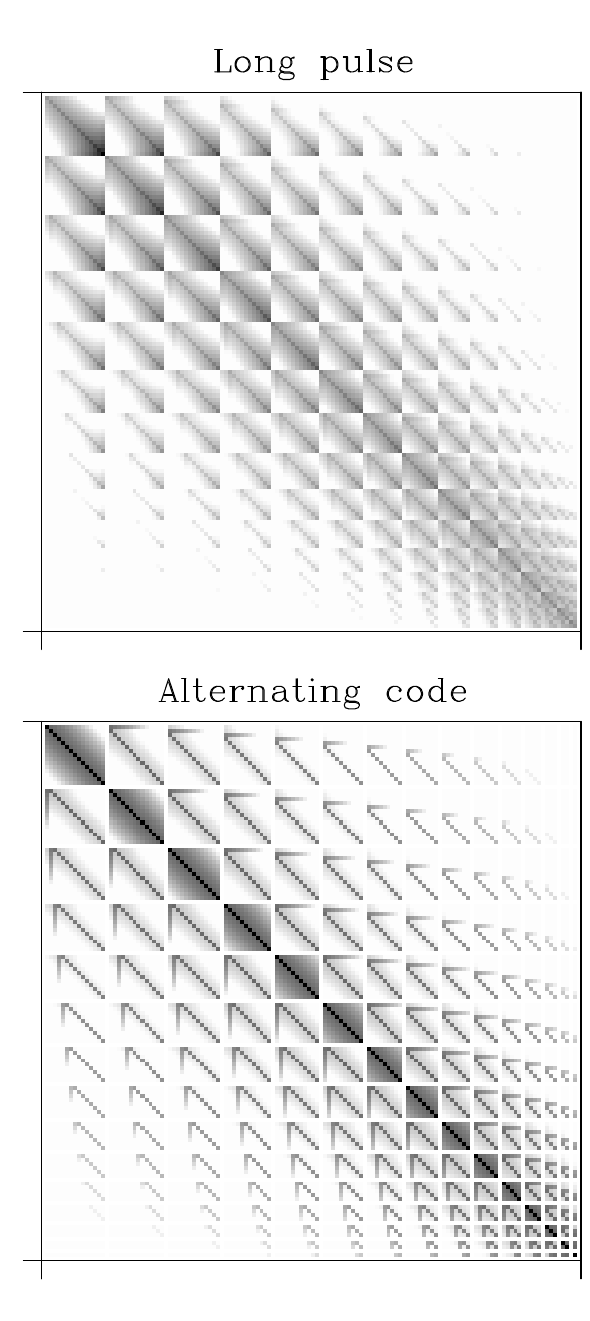
Fig. 2. Graphical representation for the error covariance matrices for representative alternating code and long-pulse experiments in the intermediate SNR limit. The covariances are real and positive in this example case and depicted with grayscales in a logarithmic format spanning 40 dB of dynamic range (see text).